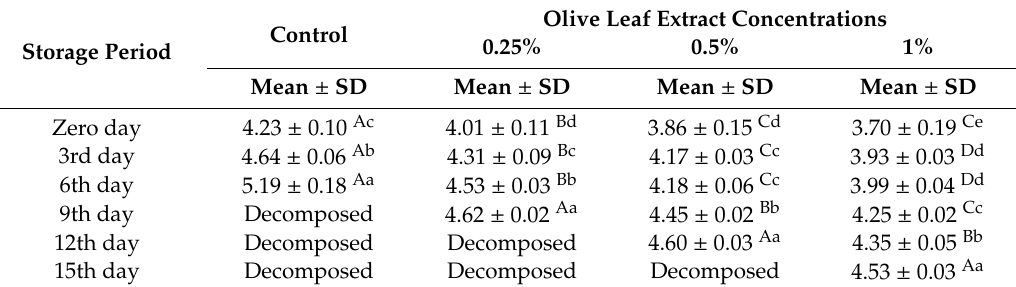
Table 6. Pattern of the psychrophilic count (log10 cfu / g) in poultry meat treated with di ff erent concentrations of olive leaf extract during the chilling storage period at 4 ± 1 ◦ C (mean ± standard deviation